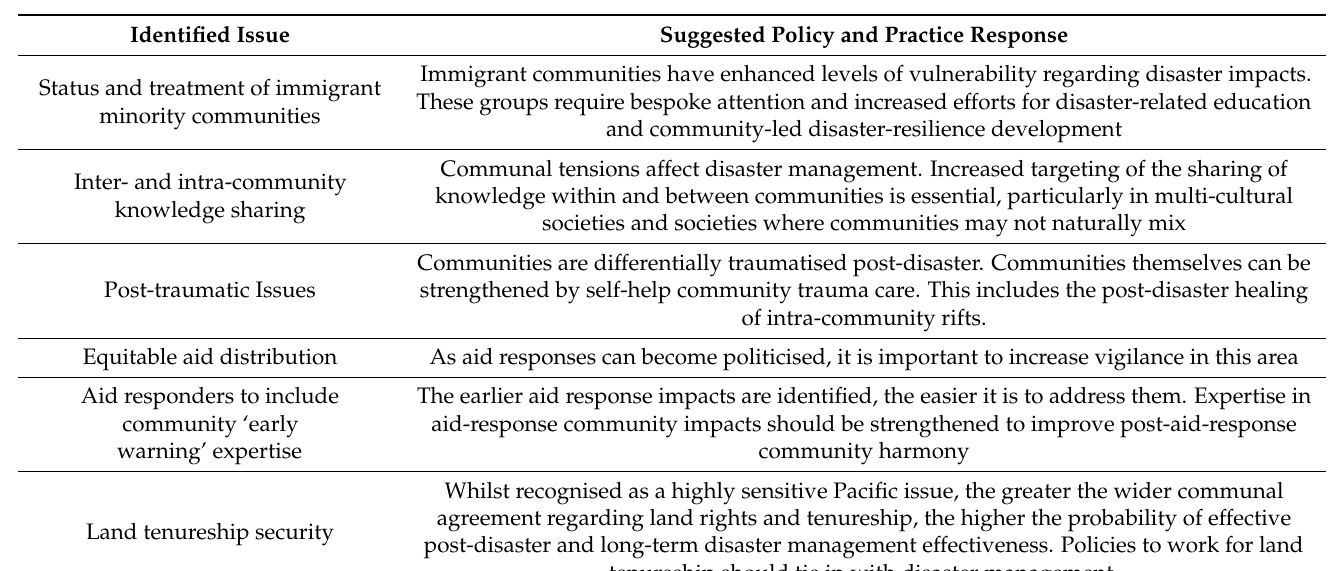
Table 8. Research-informed policy and practice recommendations for disaster and risk management from this research. Identified